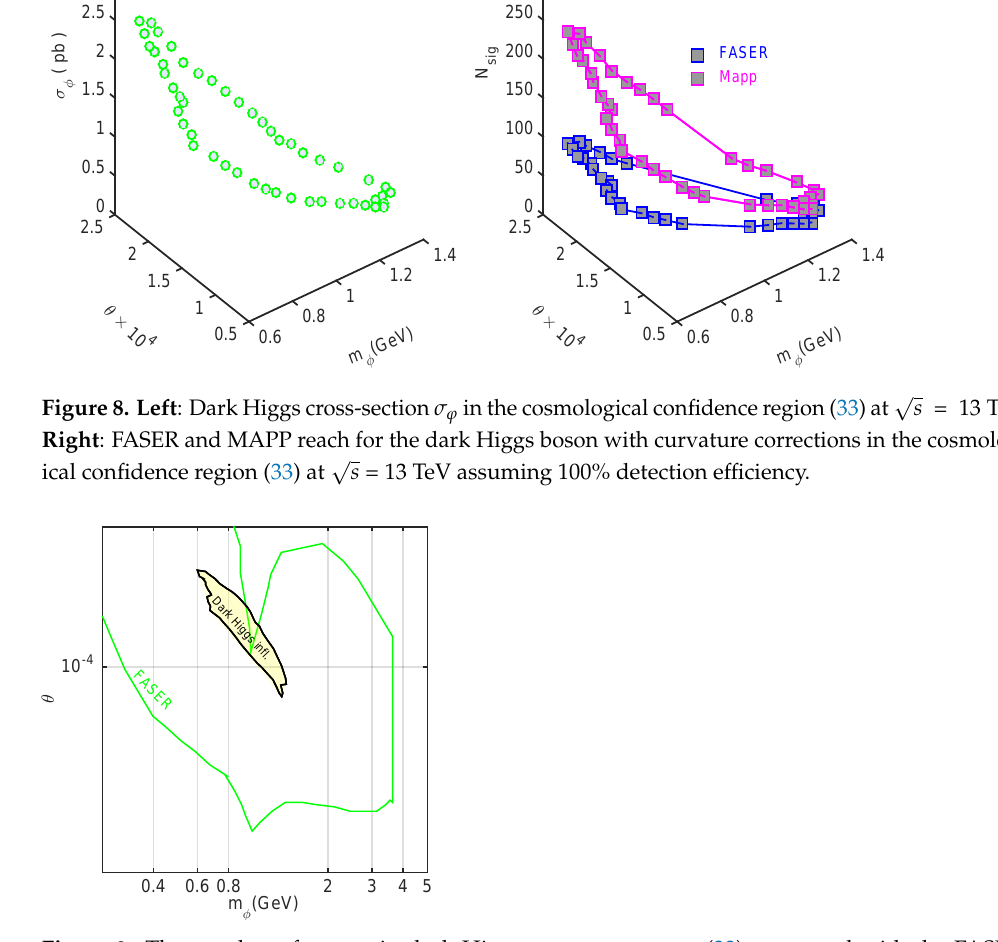
Figure 9. The number of events in dark Higgs parameter space (33) compared with the FASER √ s = 13 TeV assuming 100% detection efficiency expected number of signal events for